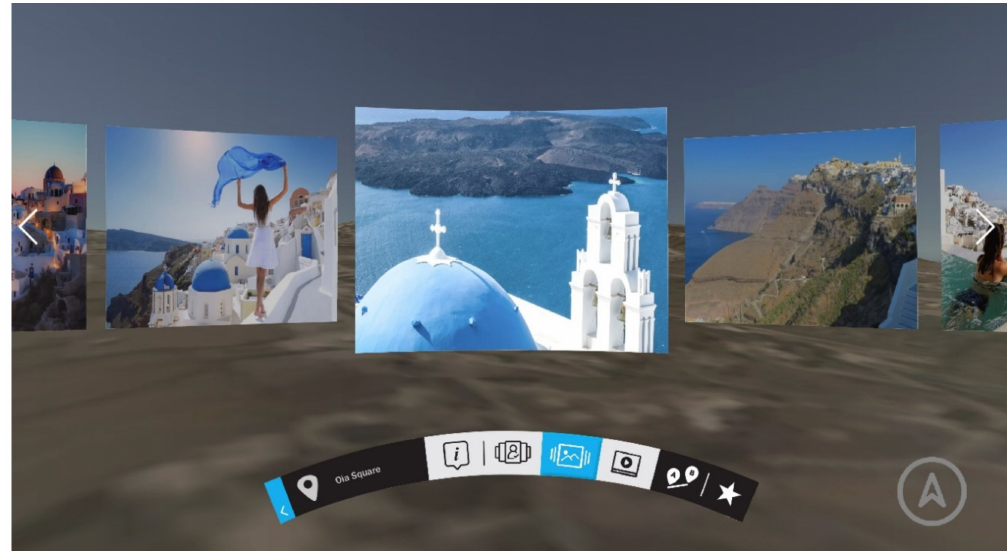
Figure 3. Multimedia selection in VR environment—Image Viewer Component showing di ff erent views (photos) of Santorini island.